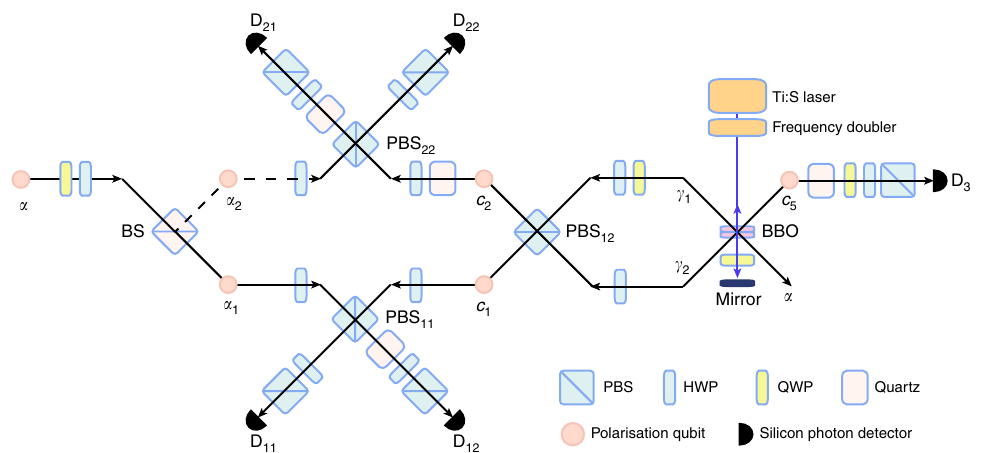
Fig. 2 Experimental setup for our all-photonic TRA Bell measurement. This setup corresponds to the measurement in Fig. 1c. Two input modes α 1 and α 2 are prepared by a 50:50 beam splitter (BS) with the incoming mode α that comes from one output mode of the SPDC at BBO. The single photon in mode α travels into α 1 or α 2 , which simulates the lossy quantum channel from Alice to Bob. The rest of the photons in modes c 1 , c 2 and c 5 generated by the SPDC at BBO forms the tripartite GHZ state necessary for TRA Bell measurement at node C. The lower and the upper type-II fusion gates tell the success/failure of the arrival of the photon from α 1 or α 2 and of the teleportation of its state to the photon in mode c 5 . The teleported state is estimated by controlling the quater wave plate (QWP), the half wave plate (HWP) and the polarising beam splitter (PBS). Quartz plates are used for adjusting additional phase shifts. All silicon photon detectors are coupled to single-mode optical fi